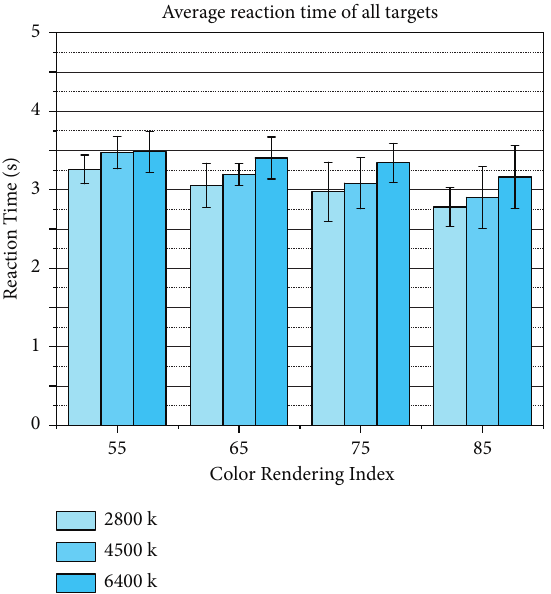
Figure 15: All colour’s average reaction time under 12 lighting